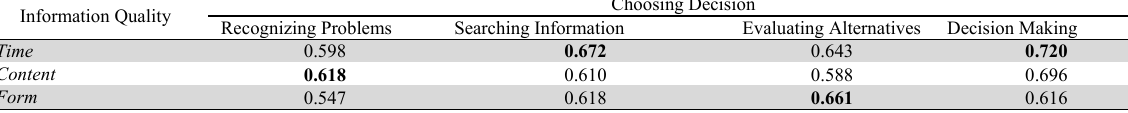
Choosing Decision